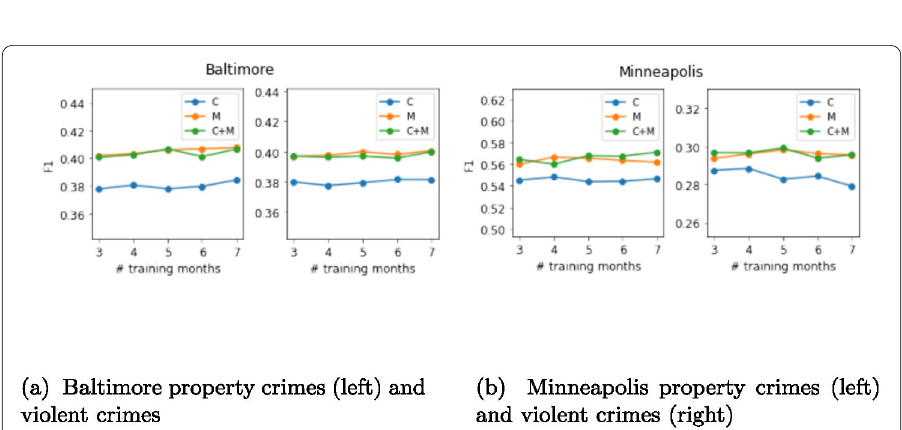
Figure 4 Average F1 score in crimes prediction using NbConv across August to December 2020 with different lengths for the look-back period. Each city has two plots: the one on the left is for property crimes and the one on the right is for violent crimes